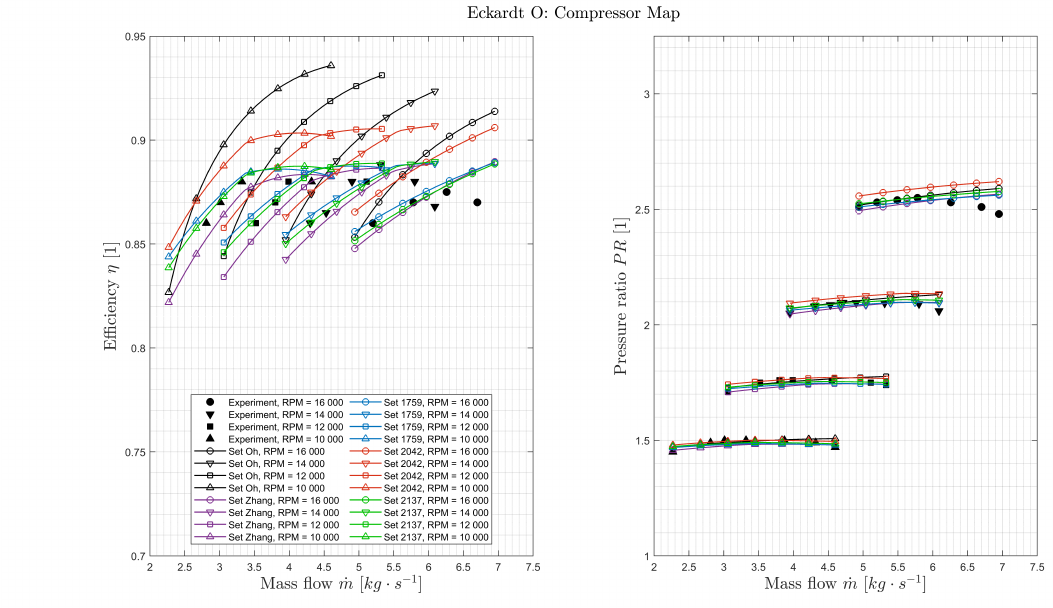
Figure 11. Eckardt O compressor map for chosen loss model sets in comparison to experimental data: ( left ) Efficiency; ( right ) pressure ratio.